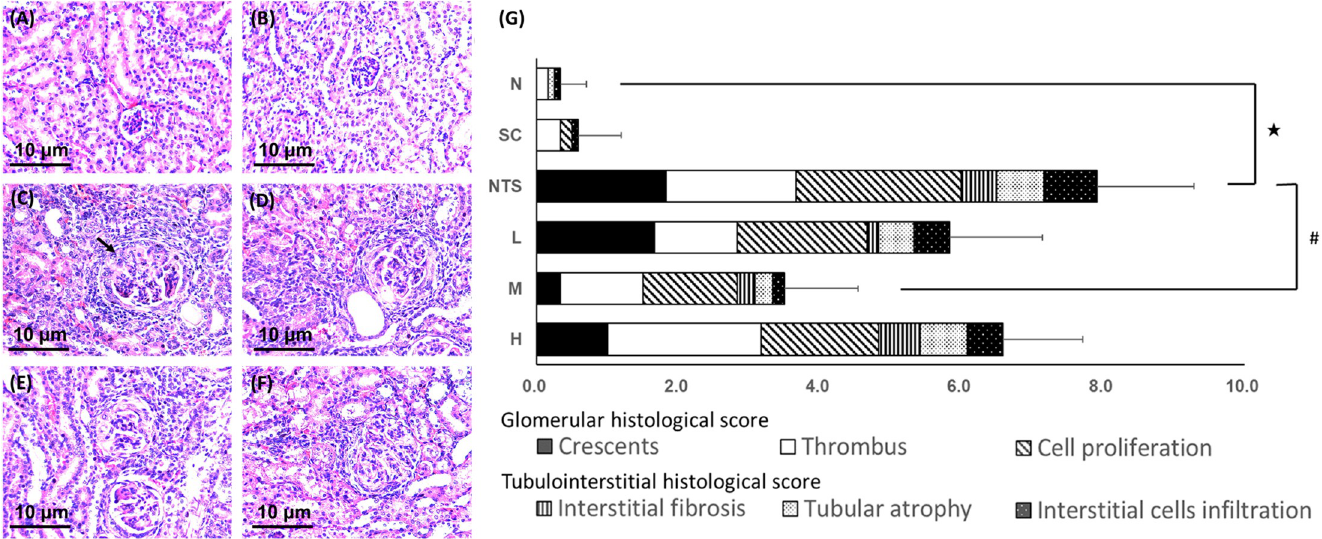
Fig 3. Hematoxylin and eosin stained renal tissue from different experimental groups ( × 200 magnification). (A) Normal, (B) SSC control, (C) NTS control (arrow: the crescent), (D) NTS + SSC 5 mg/kg, (E) NTS + SSC 10 mg/kg, and (F) NTS + SSC 20 mg/kg. (G) Histological scores for the experimental groups. $ p < 0.05 compared to N group, # p < 0.05 compared to NTS control